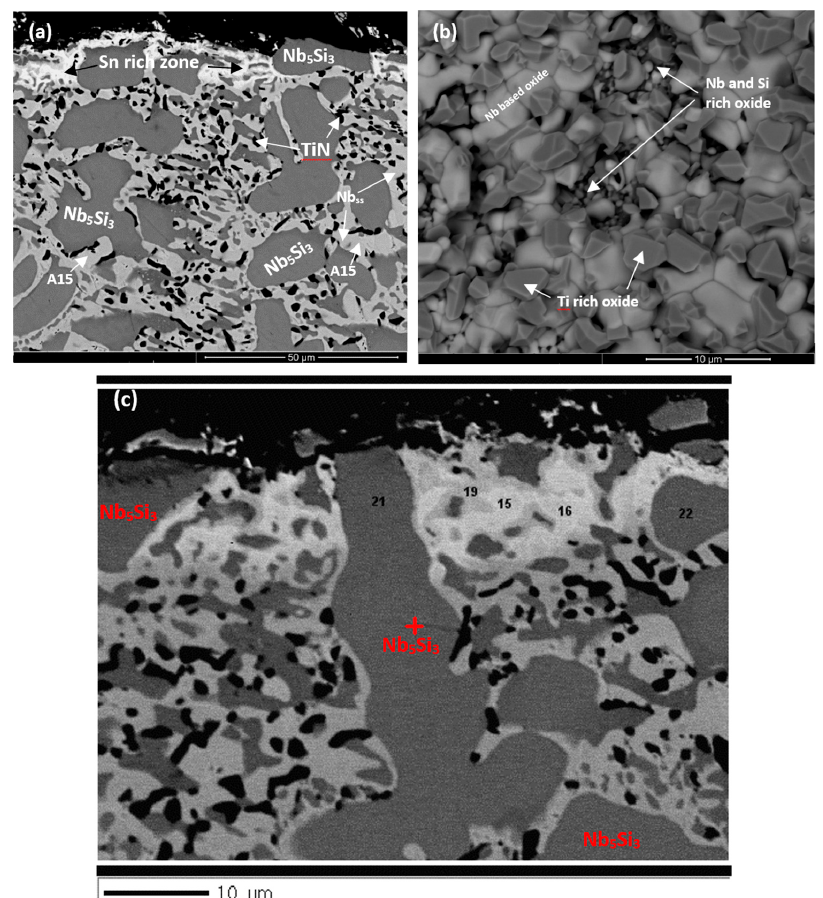
Figure 5. ( a , b ) BSE images of cross section, and X-ray elemental maps of the Sn rich zone of the oxidized alloy ZX3 at 1200 °C.